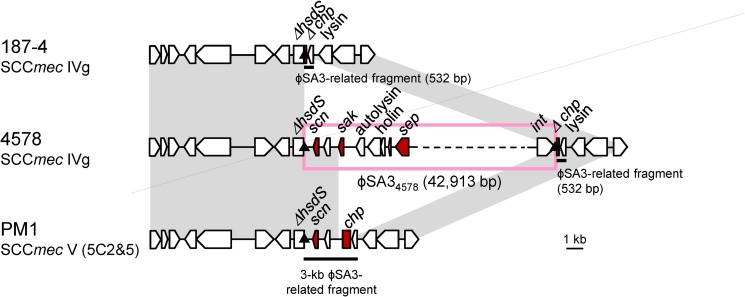
The νSaβ structure of strains 4578, PM1 and 187–4.The strains 4578 and 187–4 are ST59/SCCmec IVg MRSA carrying IEC type G or no IEC, respectively. Strain PM1 is ST59/SCCmec V (5C2&5) MRSA with IEC type C. Homologous regions are shaded. A Greek delta symbol indicates a truncated coding sequence. The att sequence is indicated by a triangle. Arrows with dashed lines indicate nearly complete coding sequence.